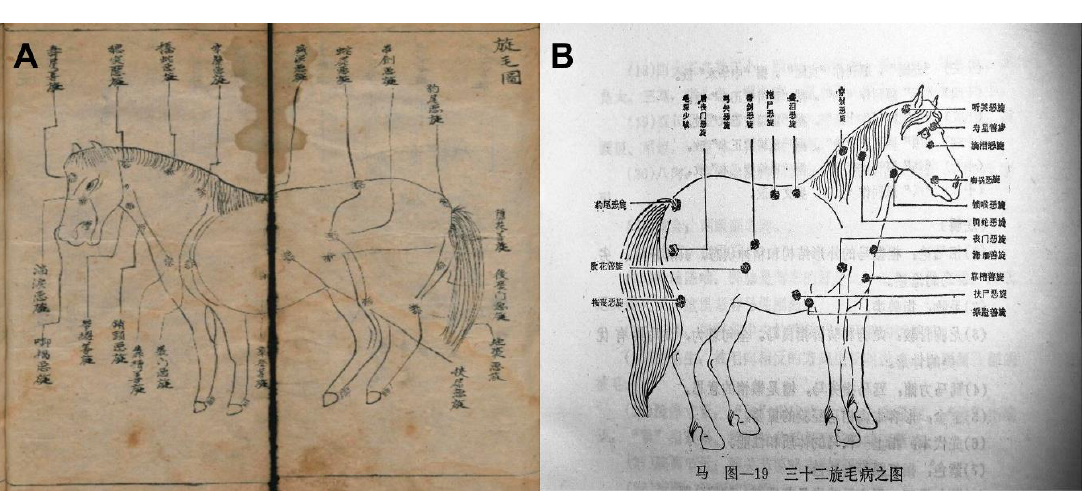
Figure 2. Illustration of the acupoints in Bo Le Ming Tang Lun [15] . One of the chapters in Yuan Heng Liao Ma Ji , Bo Le Ming Tang Lun was devoted to the application of acupuncture in the treatment of equine diseases .